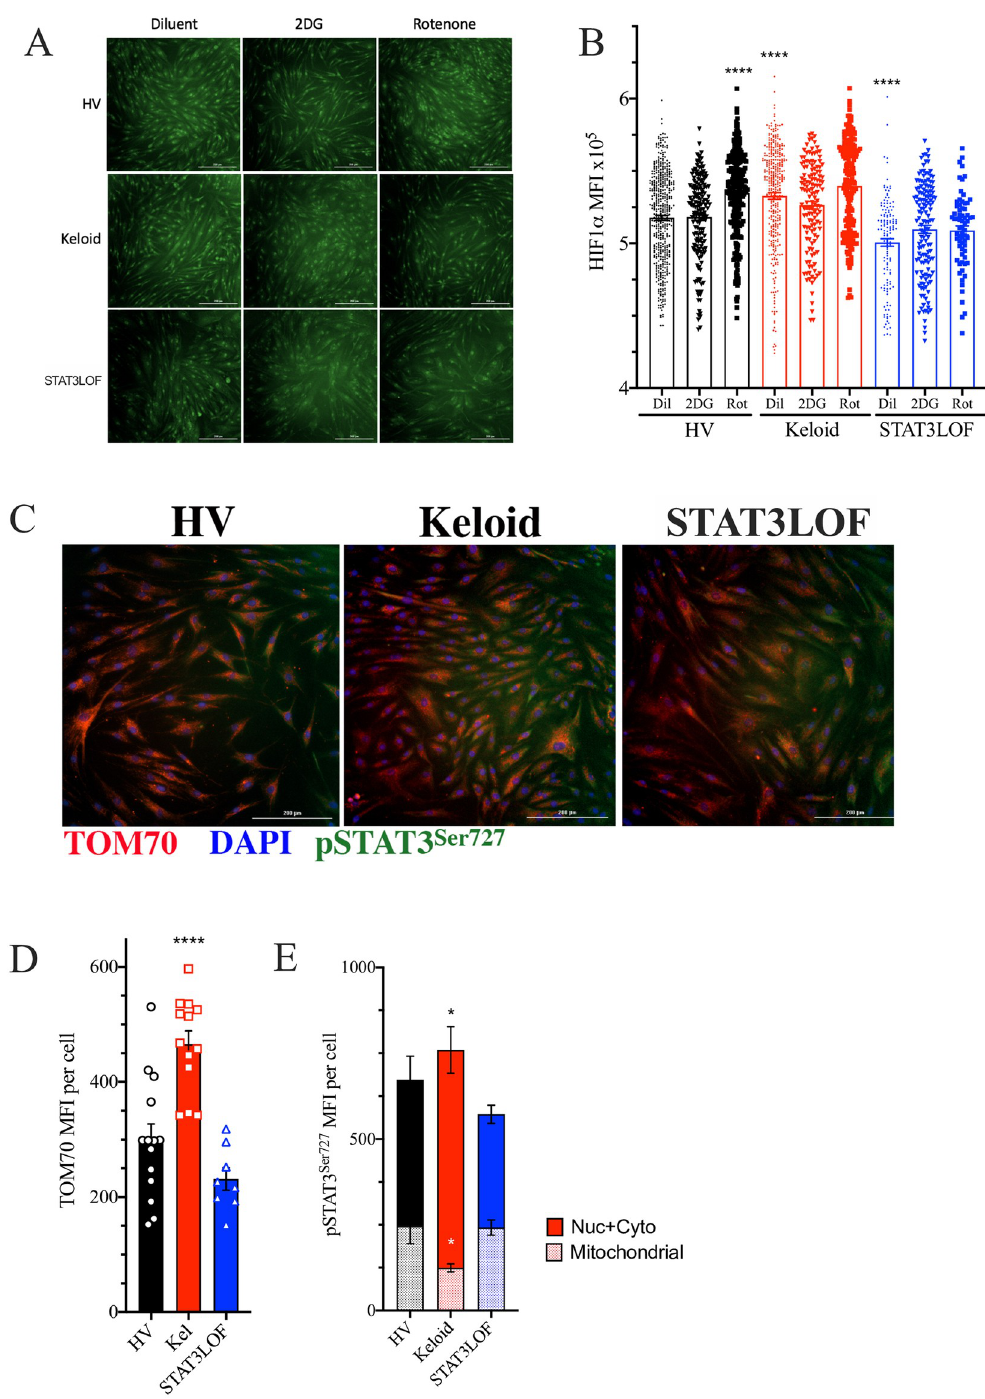
Fig 3. Keloid fibroblasts have alterations in transcriptional regulators of metabolism. (A and B) Immunofluorescent (IF) representative images (A) and quantitation of HIF1 α staining signal co-occurring with DAPI nuclear marker in each identified cell line (B), DAPI not shown to allow nuclear localization assessment. (C) Representative IF images for cells stained for TOM70 (red), phosphorylated STAT3 Ser727 (pSTAT3 Ser727 ; green), and DAPI (blue). (D and E) Signaling intensity for TOM70 (D) as well as pSTAT3 Ser727 associated with TOM70 (mitochondrial) or not associated with TOM70 (nuclear and cytoplasmic; Nuc + Cyto) (E) per cell. Results are representative of two independent experiments and displayed as mean ± SEM for triplicate wells per condition. � = p < 0.05; ���� = p < 0.0001 versus HV with diluent condition as determined by ANOVA with Sidak adjustment.